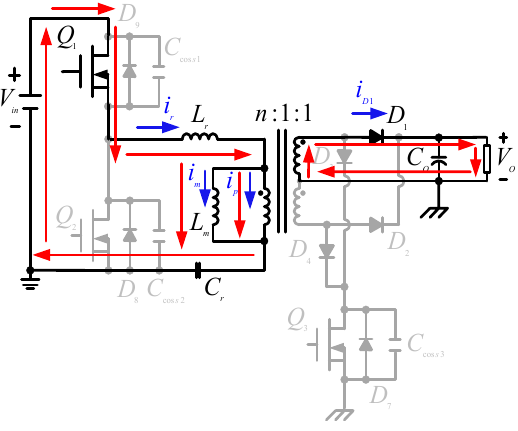
Figure 16. Working State 3 of novel LLC control circuit.